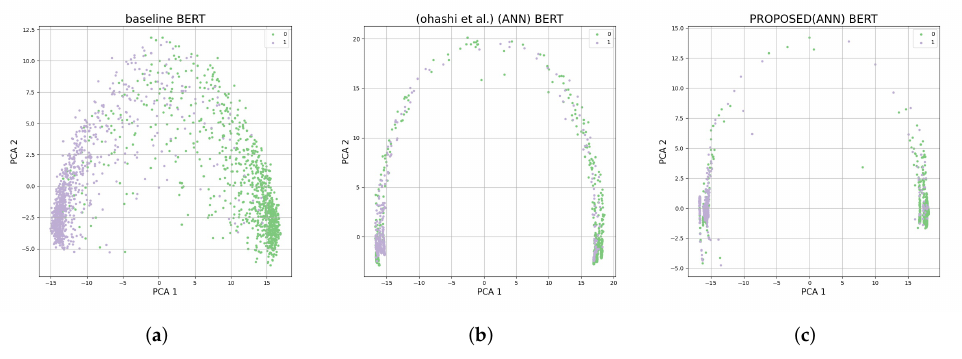
Figure 2. PCA projection of SST-2 test data’s sentence embedding. Table 7. K-means clustering with PCA in binary